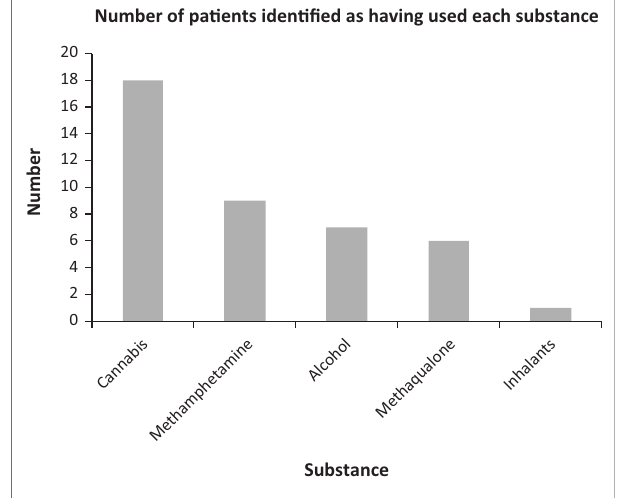
FIGURE 3: Frequency of substances used ( n = 42).